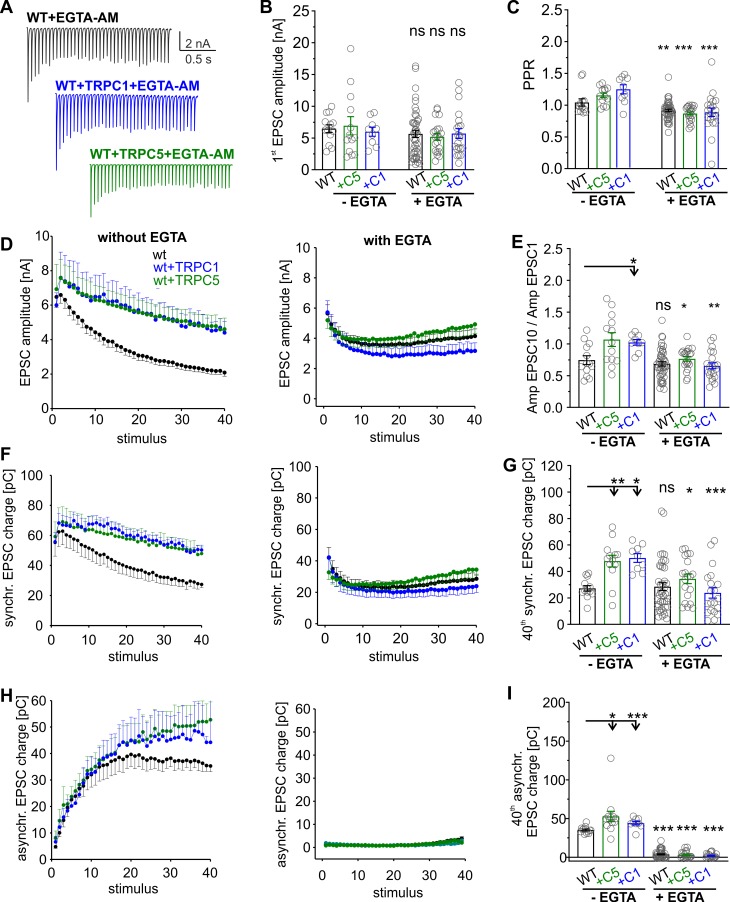
Buffering presynaptic [Ca]i abolishes TRPC-dependent short-term facilitation.(A) Representative EPSC traces for wt neurons and those expressing TRPC1 or TRPC5 after EGTA-AM treatment. EGTA abolishes asynchronous secretion causing a phase of steady-state synchronous secretion and prevents the TRPC-mediated STE of synaptic signaling. (B). Neither TRPC expression (C1 or C5) nor pretreatment with EGTA affects the first EPSC amplitude of the train response (between groups without EGTA: p = 0.7; in-group with versus without EGTA: wt, p = 0.48; +C1, p = 0.49; +C5, p = 0.67). (C) EGTA significantly reduces the PPR for all groups (in-group with versus without EGTA: wt, p = 0.03; +C1, p = 0.001; +C5, p = 2 × 10−6). (D, F, H) Activity-dependent changes of EPSC amplitude (D), synchronous release (F), and asynchronous release (H) for wt neurons and those expressing TRPC1 or TRPC5 without (left panels) and with EGTA treatment (right panels). (E and G) The TRPC-mediated increase in the AmpEPSC10/AmpEPSC1 ratio (E) and the 40th synchronous EPSC charge (panel G, last pulse of the train shown in panel F) are prevented with EGTA treatment (EPSC10/EPSC1 [between groups without EGTA]: +C1, p = 0.07; +C5, p = 0.05, versus wt; in-group with versus without EGTA: wt, p = 0.5; +C1, p = 0.00004; +C5, p = 0.028; 40th synchronous [between groups without EGTA]: +C5, p = 0.002, +C1, p = 0.0014 versus wt; in-group with versus without EGTA: wt, p = 0.36; +C1, p = 0.0004; +C5, p = 5.8 × 10−9). (H and I) EGTA treatment diminishes asynchronous secretion in all groups, indicating effective buffering of presynaptic [Ca]i (+C5, p = 0.0008, +C1, p = 0.05; in-group with versus without EGTA: wt, p = 1.4 × 10−12; +C1, p = 0.0000003; +C5, p = 5.8 × 10−9). Data was collected from EGTA-treated wt (n = 45), wt + TRPC1 (n = 21), and wt + TRPC5 (n = 21) cells and nontreated wt (n = 13), wt + TRPC1 (n = 9), and wt + TRPC5 (n = 13) cells. *p < 0.05, one-way ANOVA on ranks followed by Dunn’s post hoc test for groups without EGTA; **p < 0.01, ***p < 0.001, Mann-Whitney U rank sum test for the in-group comparison with and without EGTA treatment. Underlying data can be found in S1 Data. EGTA-AM, ethylene glycol-bis(β-aminoethyl ether)-N,N,N′,N′-tetraacetic acid acetoxymethyl ester; EPSC, evoked postsynaptic current; ns, not significant; PPR, paired-pulse ratio; STE, short-term enhancement; TRPC, transient receptor potential canonical; wt, wild type.